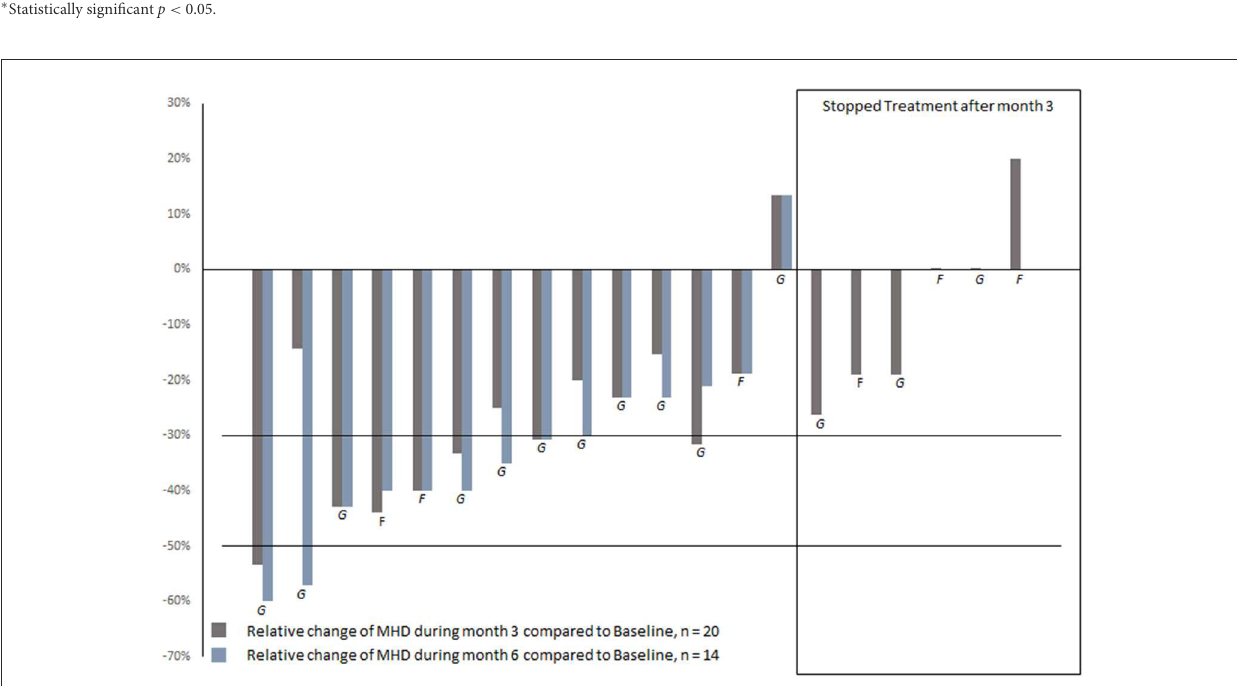
FIGURE2 Reduction of MHD during month 3 and 6 of treatment with erenumab, compared to baseline. G, galcanezumab as prior CGRP ligand mAb; F, fremanezumab as prior CGRP ligand mAb.